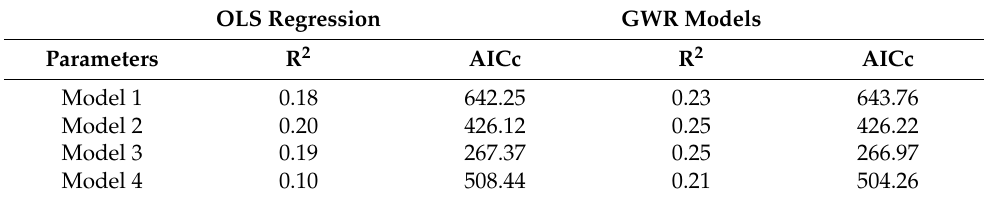
Table 5. Performance comparison between OLS regression and GWR models.